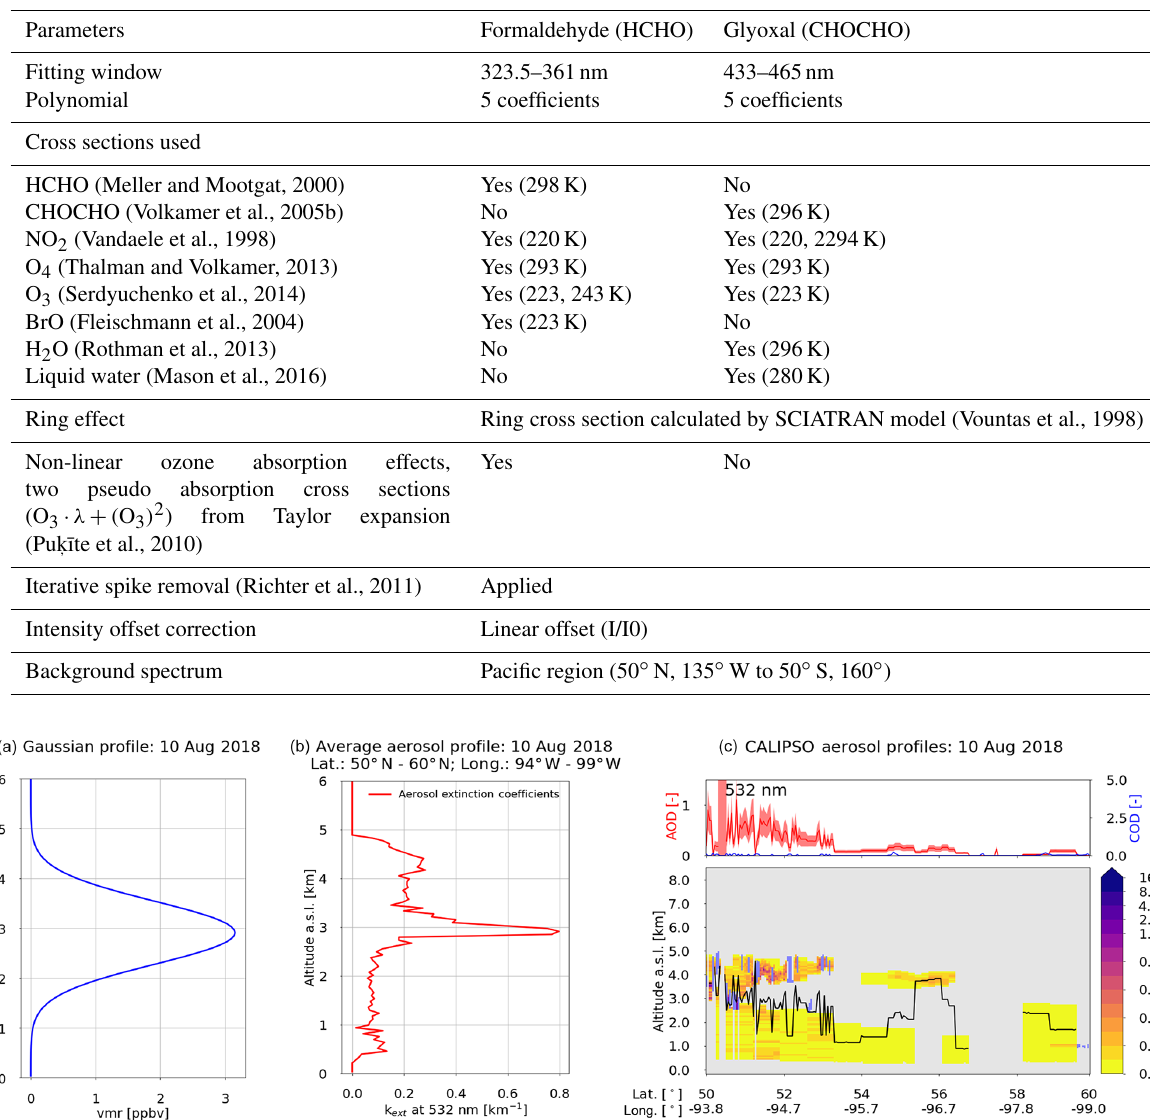
Table 1. Summary of retrieval parameters of CHOCHO and HCHO from S5P with the respective absorption cross sections used.